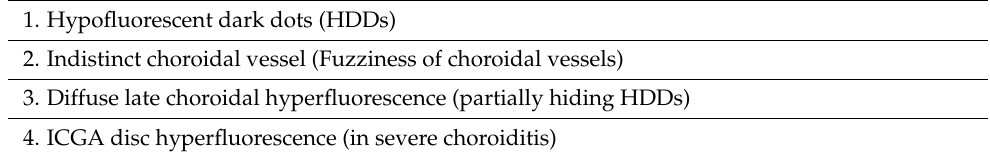
Figure 6. Indocyanine green angiography (ICGA), type 2 pattern found in stromal choroiditis. ( A ): Typical round HDDs of similar size evenly distributed caused by the presence of inflammatory foci that impair the diffusion of the ICG dye showing granulomas in negative in case of Vogt- Koyanagi-Harada (VKH) disease. Choroidal vessels are no more distinct and appear fuzzy with diffuse hyperfluorescence hiding the HDDs. ( B ): After three days of intravenous corticosteroids, the choroidal vessels are again distinctly visible, and HDDs have partially resolved. Table 1. ICG angiographic signs in stromal